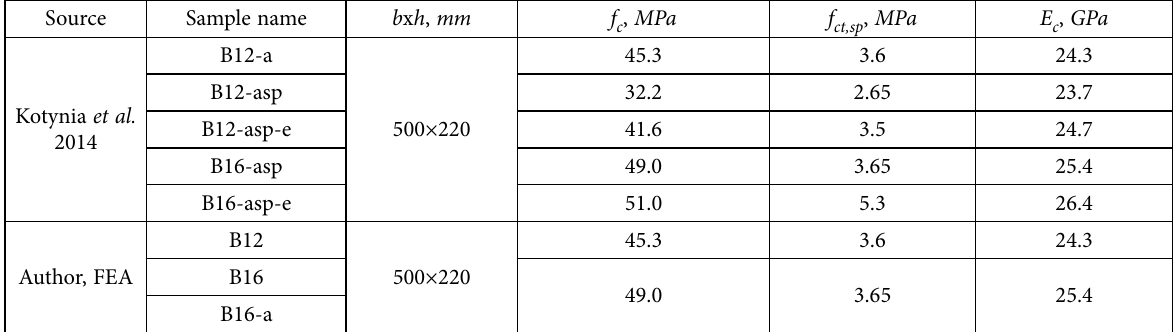
Table 2. Mechanical parameters of